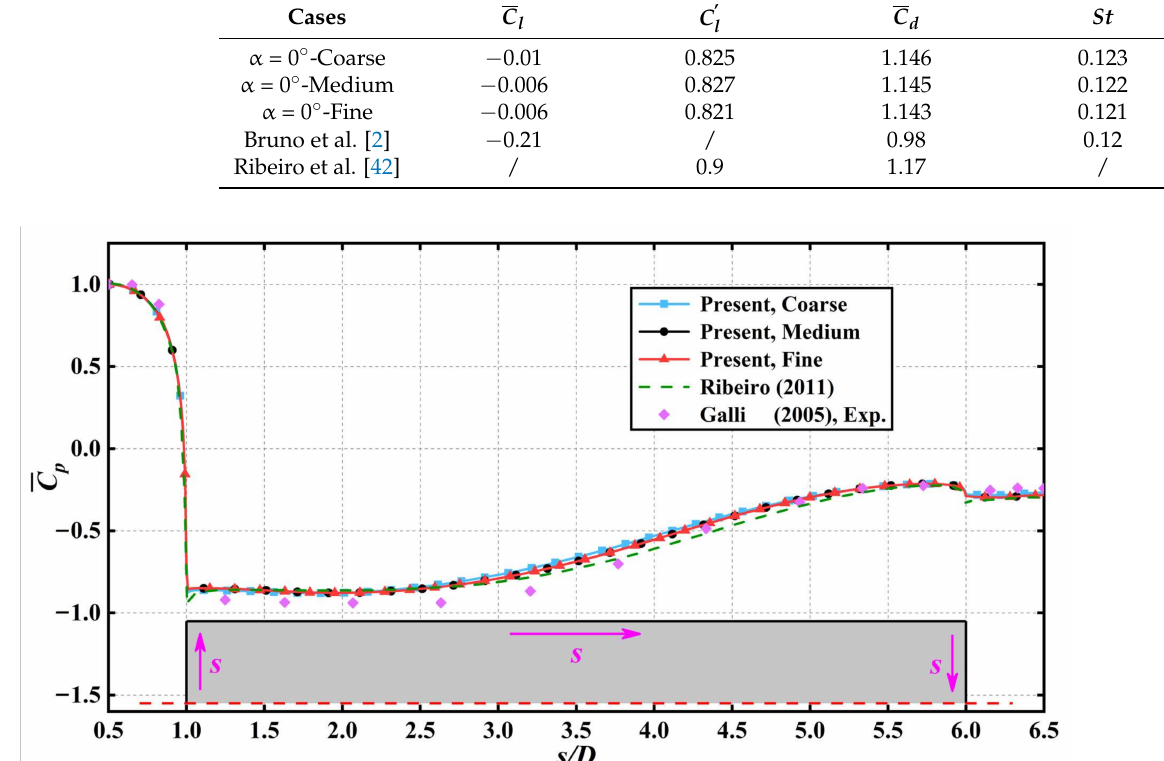
Figure 3. Distribution of the time-averaged pressure coefficient on the top side of the cylinder